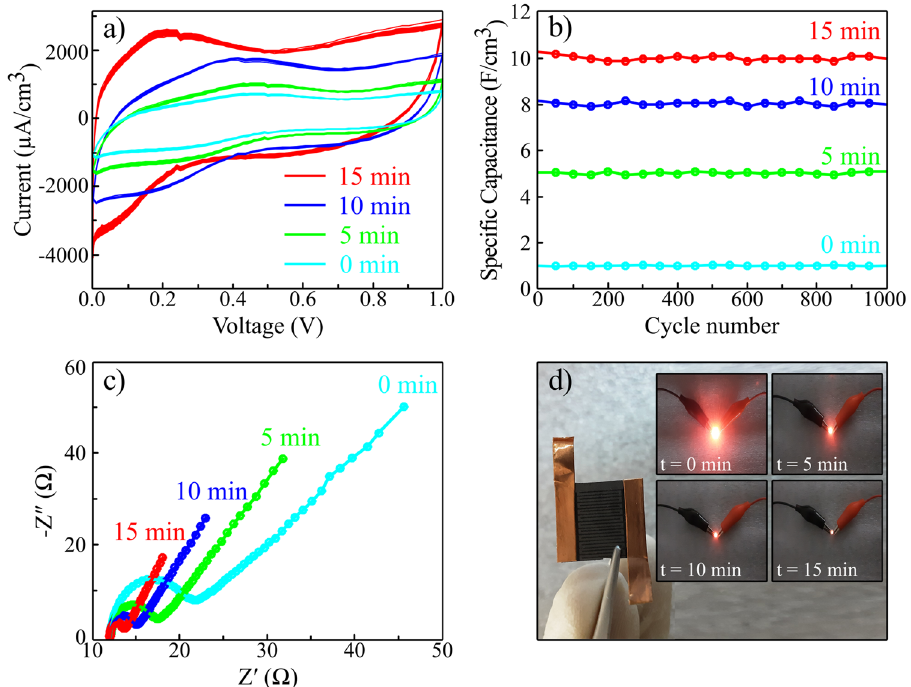
Figure 9. ( a ) Cyclic voltammetry test of r(F + O)rGO samples with different plasma exposure times from 0 to 15 min for 50 selected cycles from 1000 to 1050. ( b ) Stability test of resulted capacitances for 1000 continuous charge–discharge cycles. ( c ) Electrochemical Impedance Spectroscopy of the obtained electrodes with different plasma treated times. ( d ) Photograph of the two-electrode 15 min plasma treated r(F + O)rGO supercapacitor. Insets: photograph of the red LED being lighted up by the corresponding